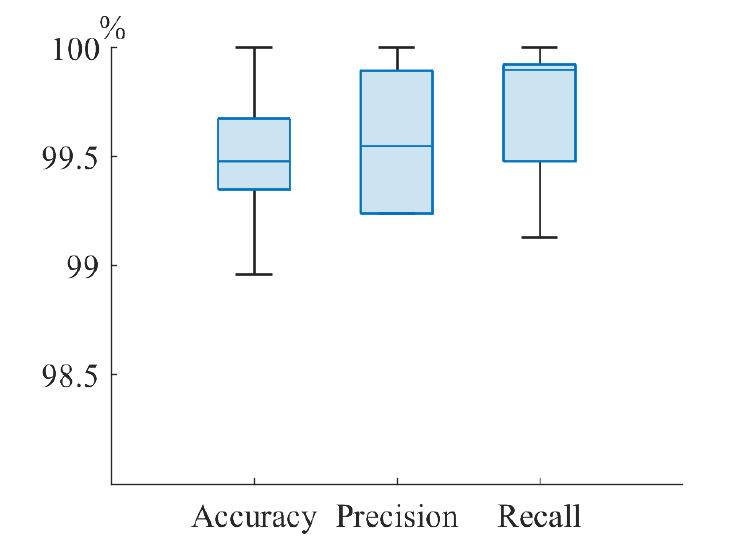
Figure 7. CNN cross-validation results on the training dataset. Table 3. Results of T1DM and healthy volunteer classification by infrared breath spectra. Group Accuracy Precision Recall All 99.7 99.5 99.6 Male 99.5 98.6 100 Female 99.7 99.9 99.8 Minors (less 14 y.o.) 99.5 99.6 99.5 Adults (more 14 y.o.) 98.9 99.3